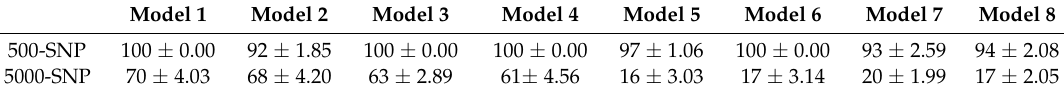
Table 2. Mean power of IEACO with its respective standard deviation.